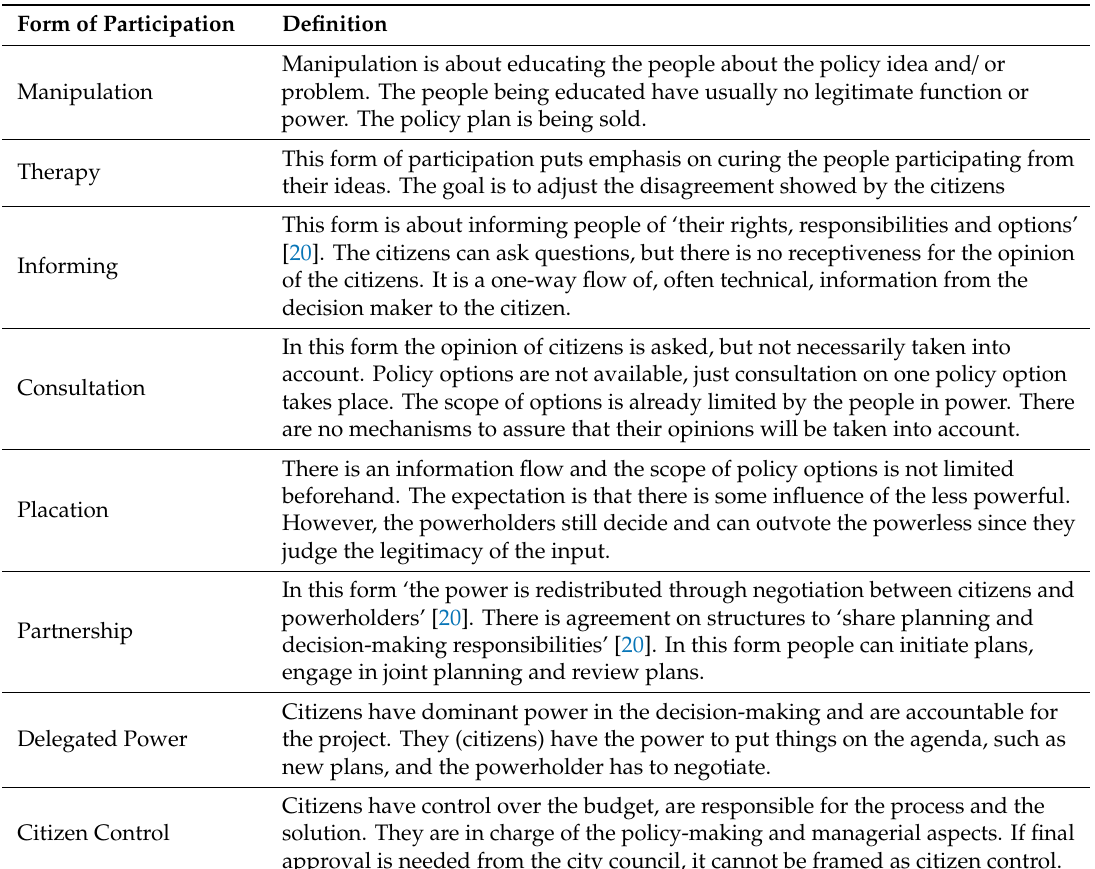
Table 1. Forms of participation identified by Arnstein